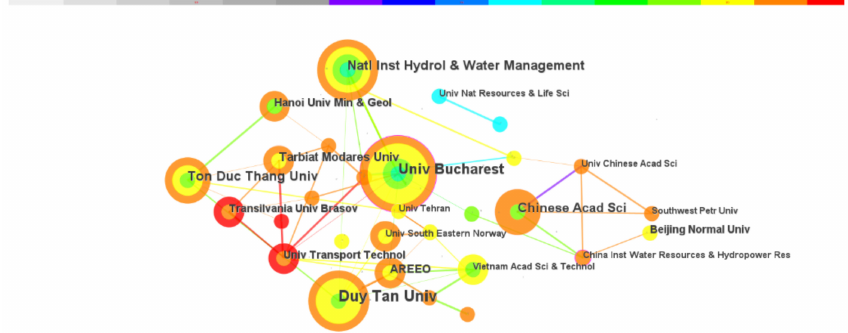
Figure 12. Co-operation network diagram of institutions for publishing documents.